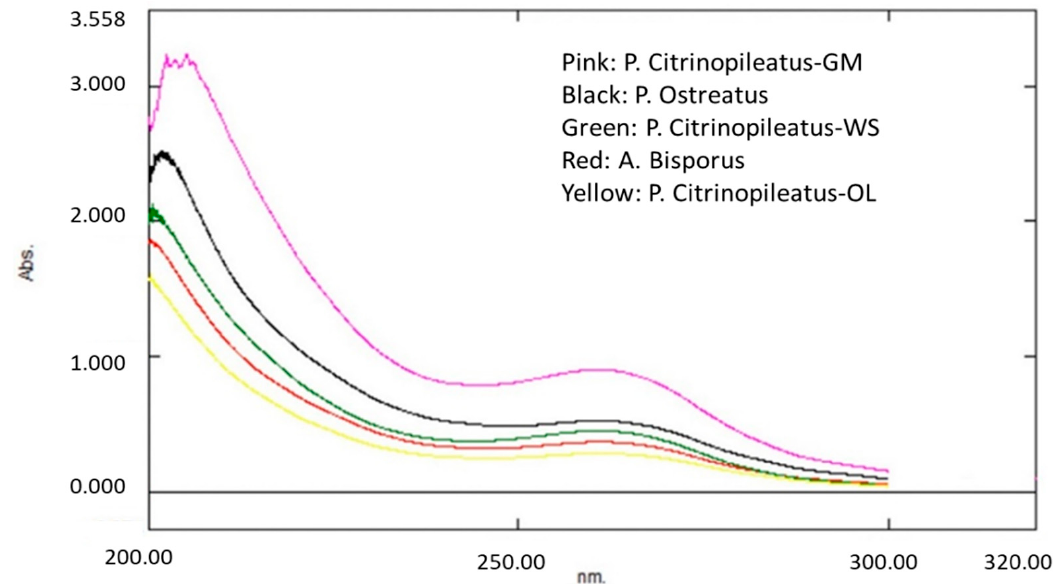
Figure 1. Ergothioneine ultra-violet spectroscopy (UV–Vis) spectra of mushrooms of three species, i.e., A. bisporus , P. ostreatus , and P. citrinopileatus . The latter was cultivated in three substrates (wheat straw (WS), grape marc (GM), and olive by-products (OL)).